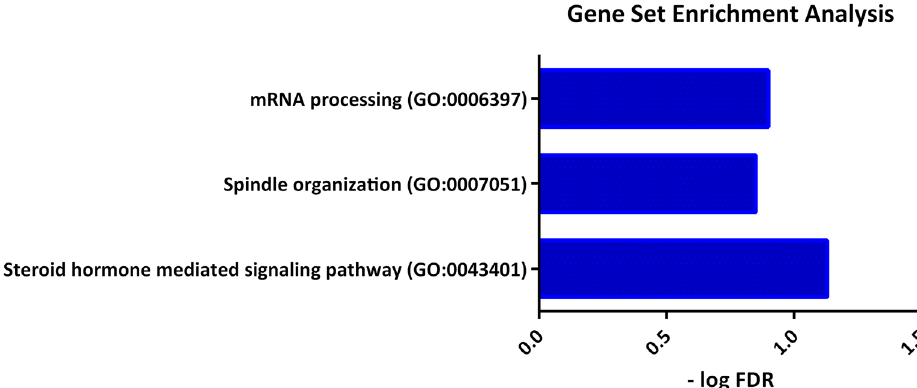
Figure 3. Biological process enrichment analysis. Enriched terms based on biological process for all genes involved in the statistically significant triplets.